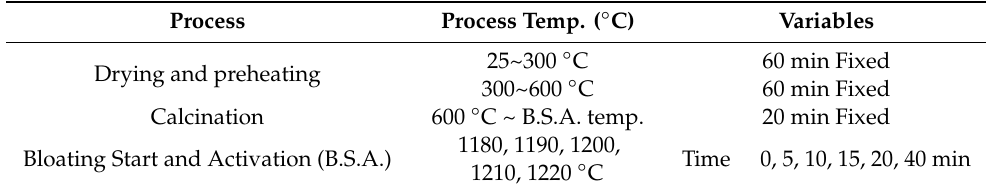
Table 4. Additional experimental conditions for model